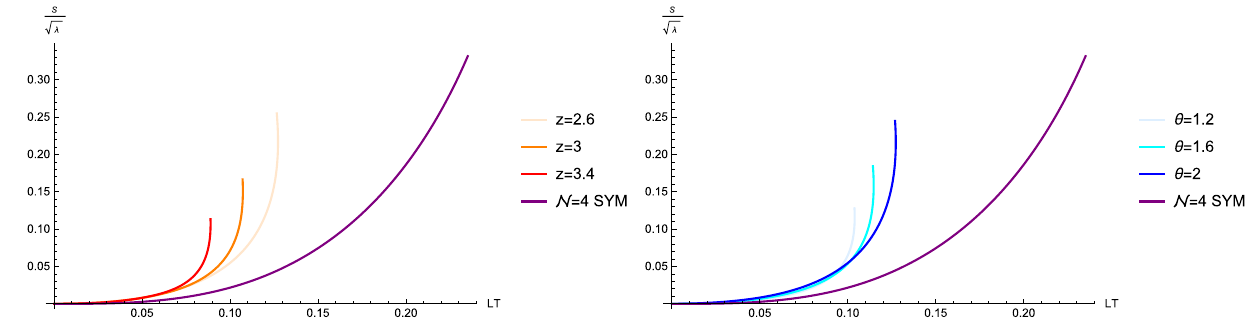
√ λ versus LT in different values of z at θ = 2 and μ/ T = 8. Right: S / Fig. 4 Left: S / μ/ T = 8